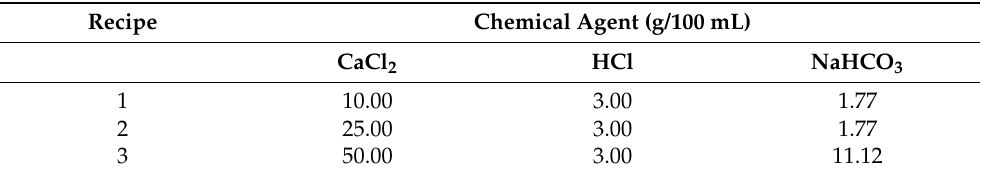
Table 1. CaCl 2 treatment recipes of the cotton/elastane fabrics.